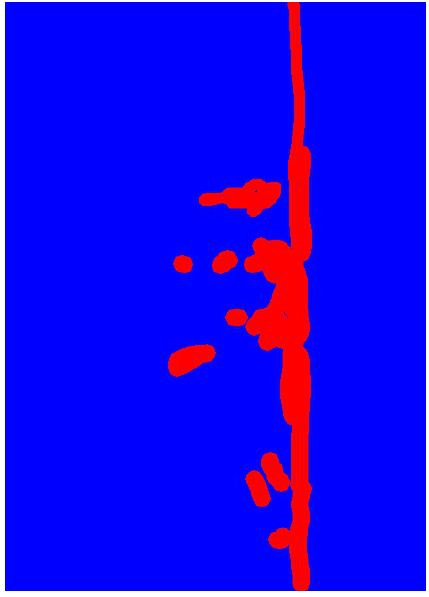
Figure 6. The ground truth picture (@500 × 700) after the perspective transformation. Blue is road background, red is trash and